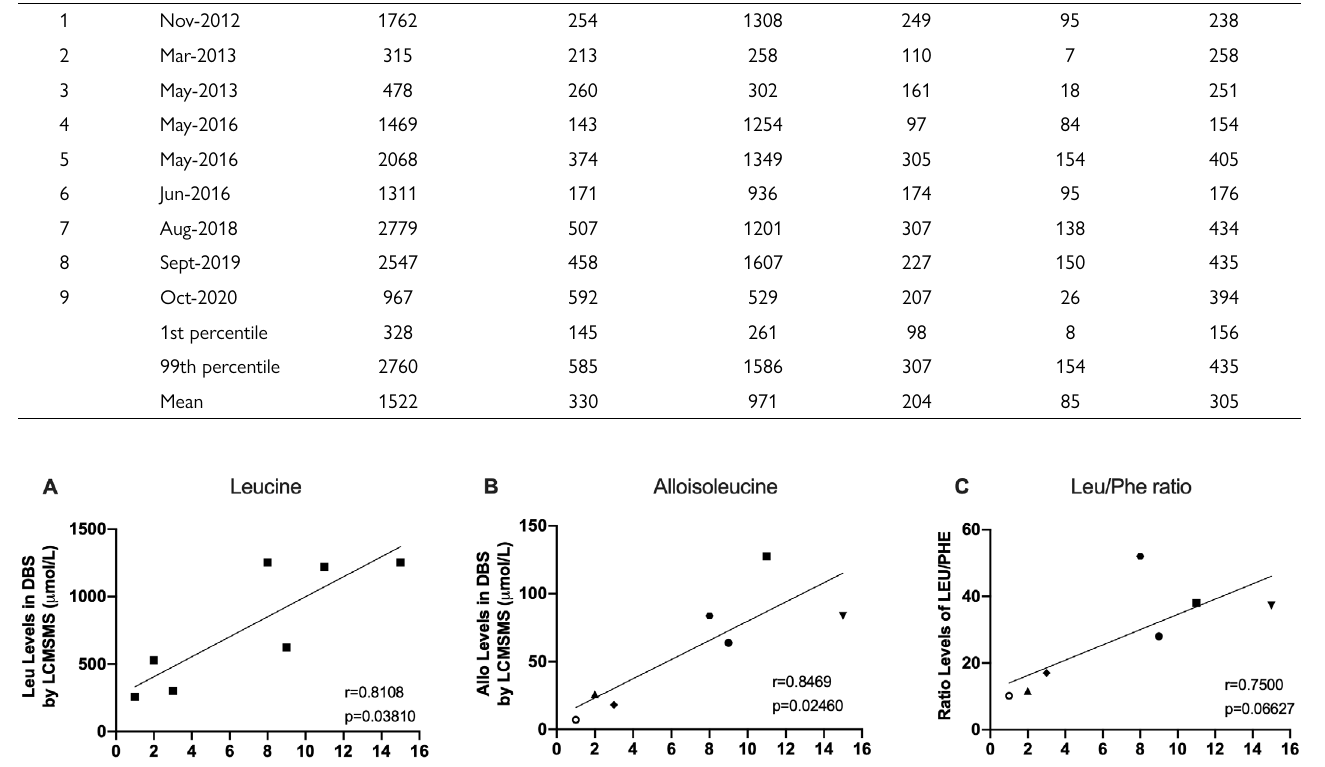
Table 1. BCAAs levels in first dried blood spot samples from MSUD patients. Retrospective analysis by two methods MSMS and LC-MSMS. Patient #